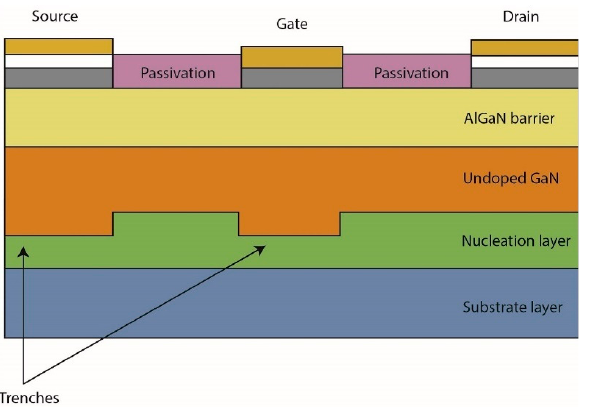
Figure 20. Illustration of a GaN-based HEMT with dual trench structures formed between the un- doped GaN and the nucleation